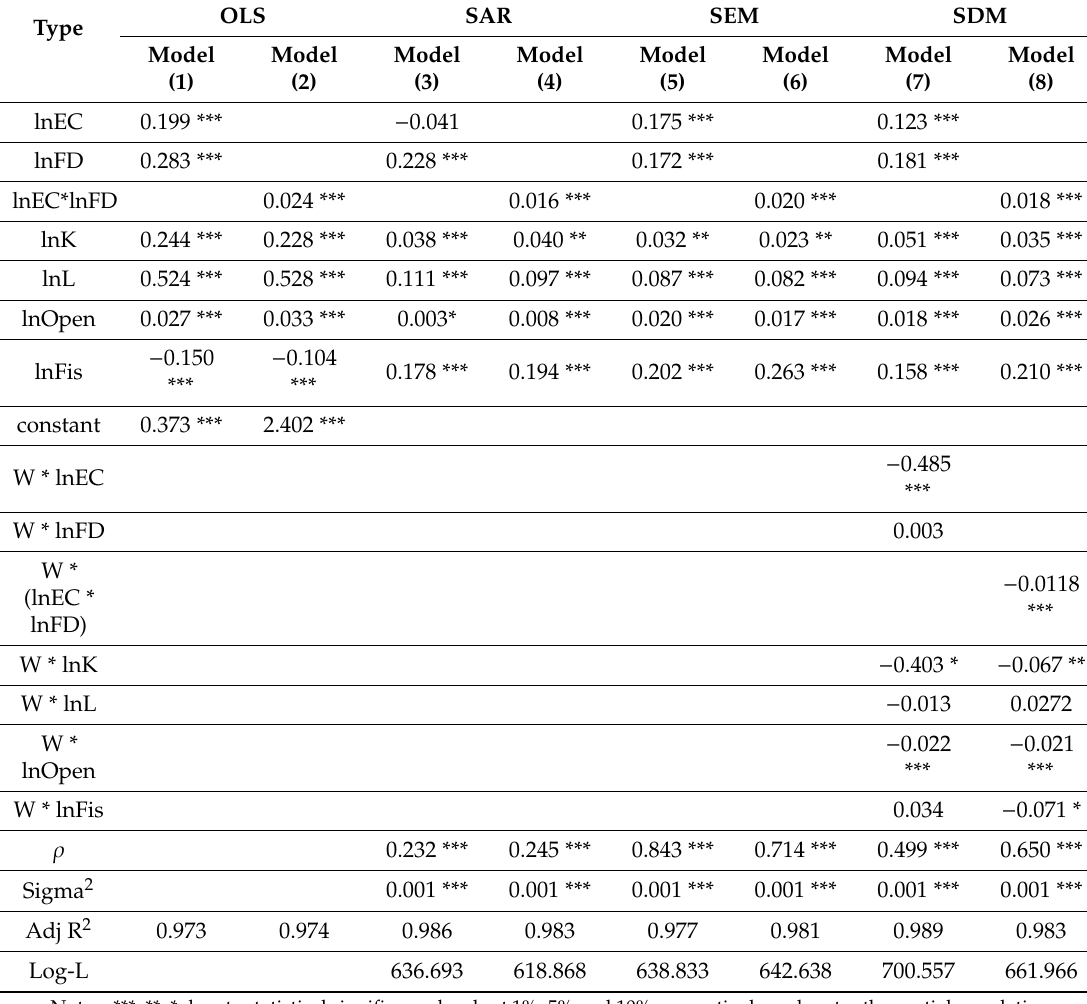
Table 1. Model comparison of ordinary least squares (OLS), spatial autoregressive model (SAR), spatial error model (SEM), and spatial durbin model